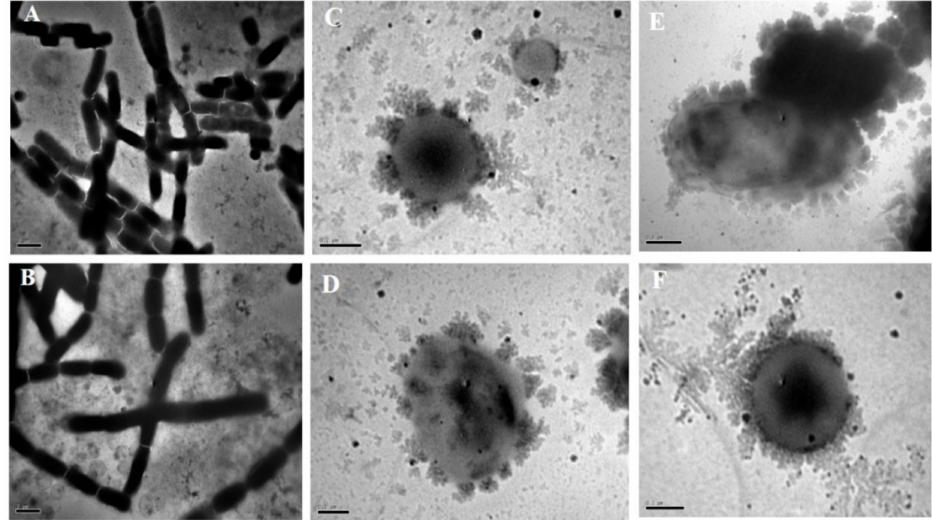
Figure 3. Effect of the tested compounds 3 , 12 , 13 , 14 and 16 on structural identity of Pseudomonas sp. TEM Microgram of Pseudomonas sp. (Control, ( A )) and presence of compounds 3 ( B ), compound 12 ( C ), compound 13 ( D ) and compound 14 ( E ) and compound 16 ( F